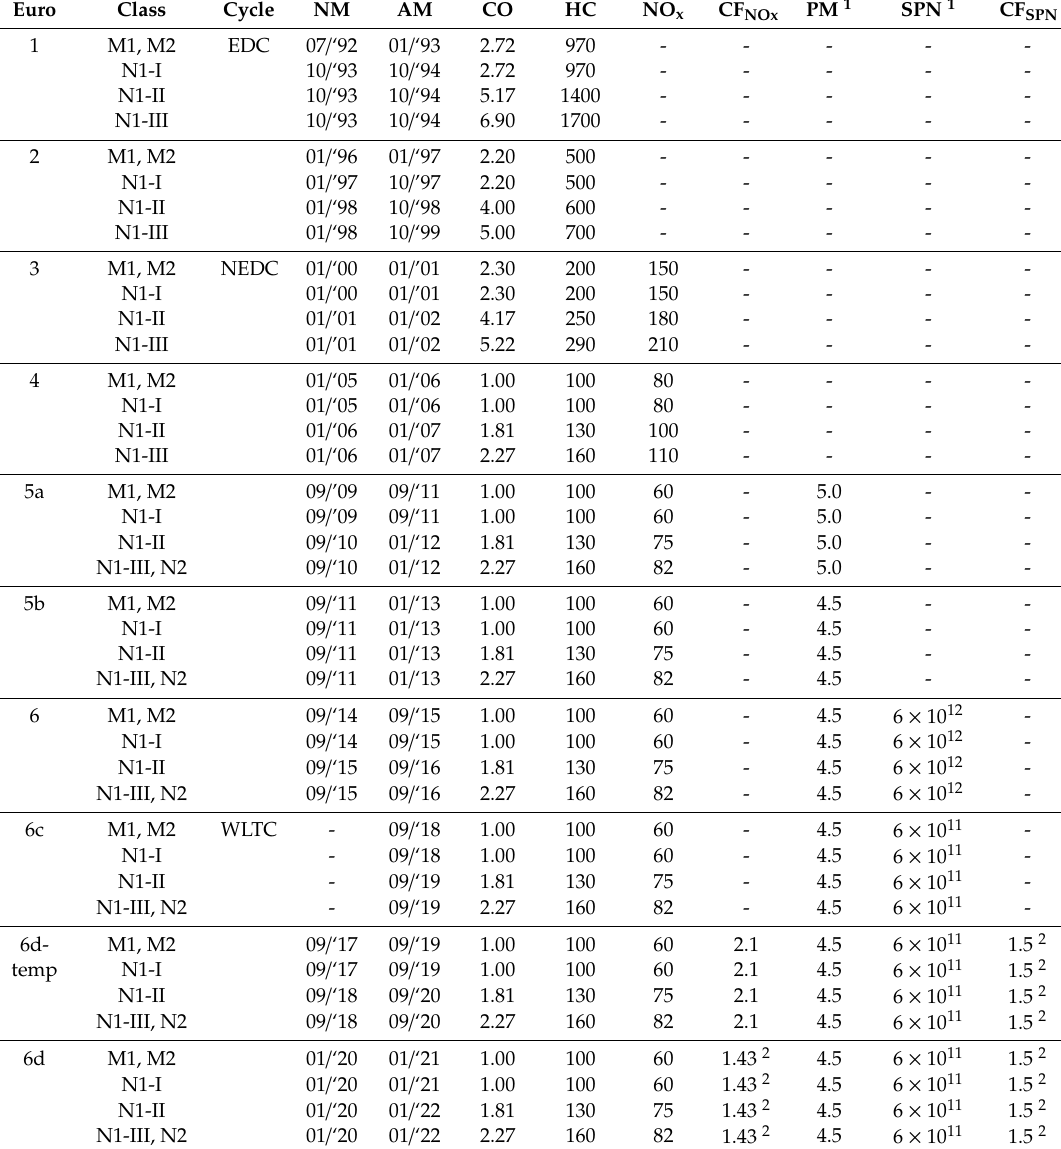
Table 2. European Union (EU) emission standards for positive ignition (PI) light-duty vehicles (g / km for CO, mg / km for HC, NO x , PM, and p / km for